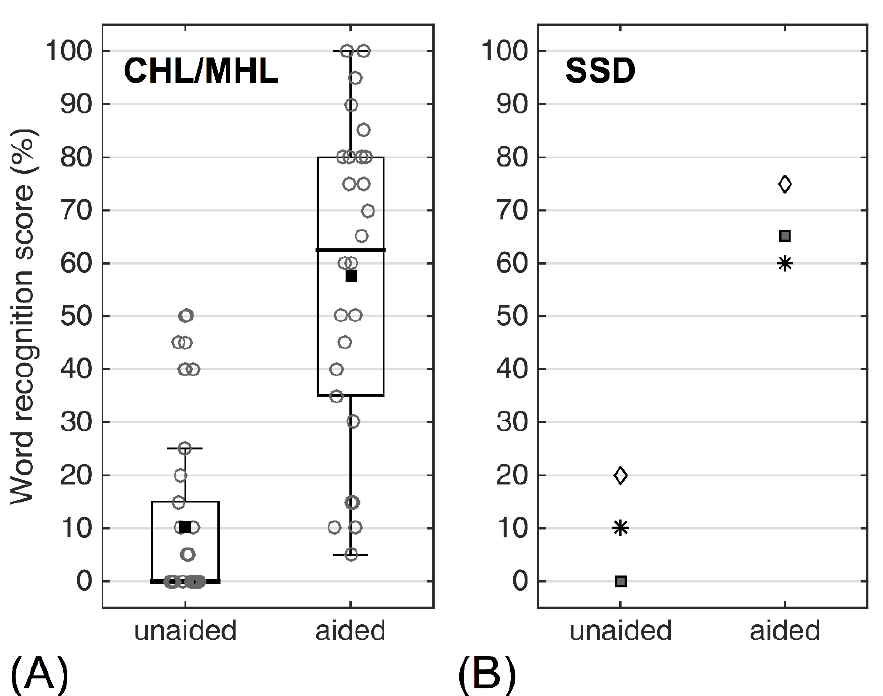
Figure 4. Word recognition scores with and without the BB postoperatively acquired for ( A ) patients with MHL/CHL. Bold horizontal lines indicate the median; black squares denote the mean. ( B ) SSD patients, where each symbol denotes values for a specific individual.